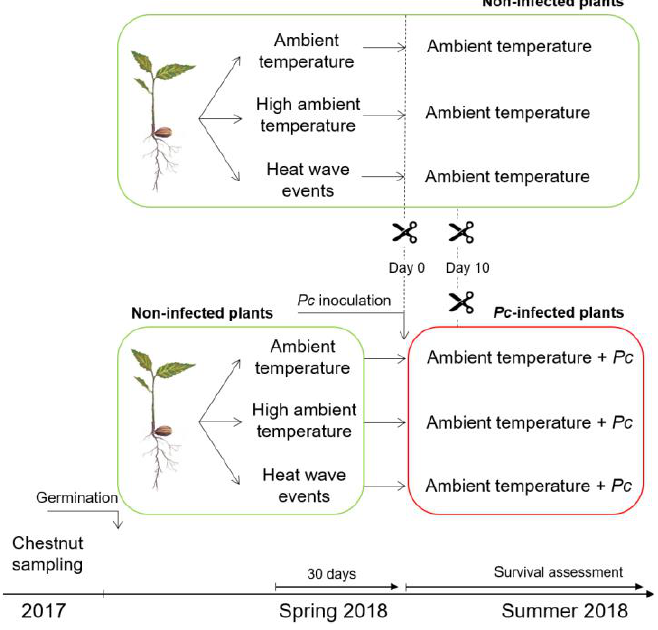
Figure 8. Experimental design and sampling plan.